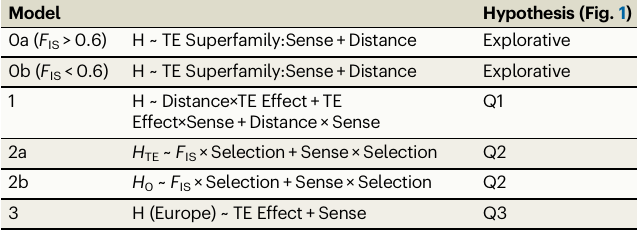
Table 1 | List of generalized mixed models used to test our three main hypotheses Model Hypothesis (Fig.